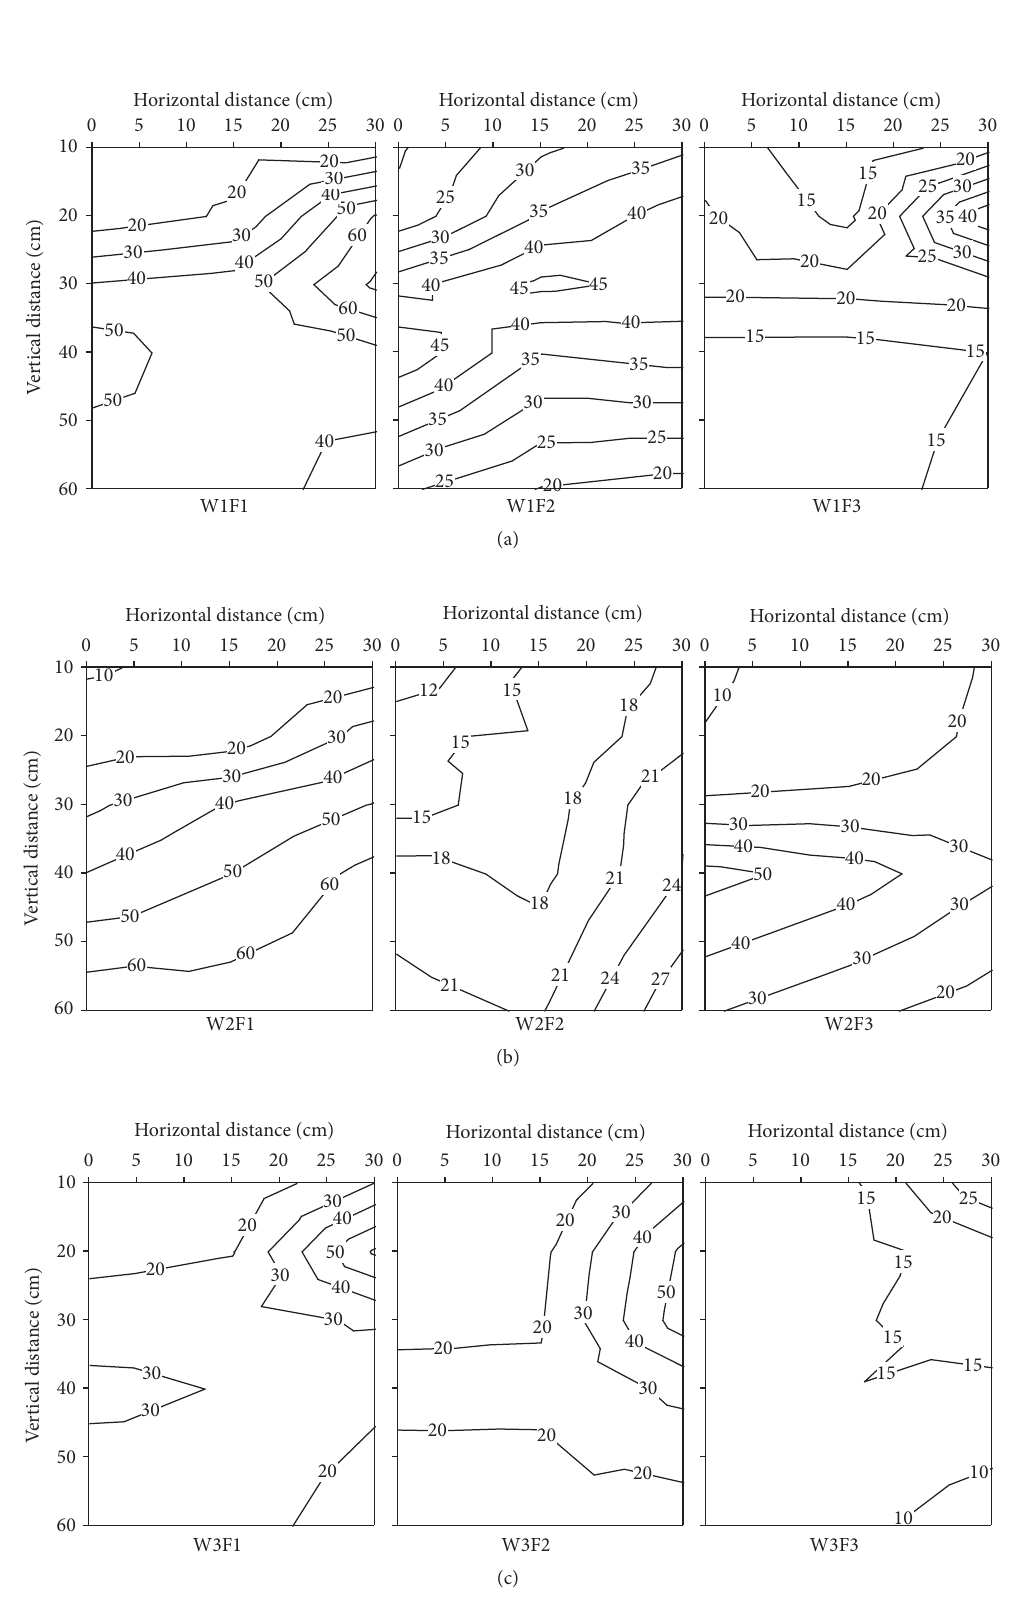
Figure 3: The effects of different irrigation and fertilization on vertical distribution of soil NO 3− -N content in root zone soil of different treatment at 25 days after transplanting in 2012. W1: 100% ET 0 , W2: 75% ET 0 , and W3: 50% ET 0 ; F1: N240–P 2 O 5 120–K 2 O150 kg hm −2 ; F2: N180–P 2 O 5 90–K 2 O112.5 kghm −2 ; and F3: N120–P 2 O 5 60–K 2 O75 kg hm −2